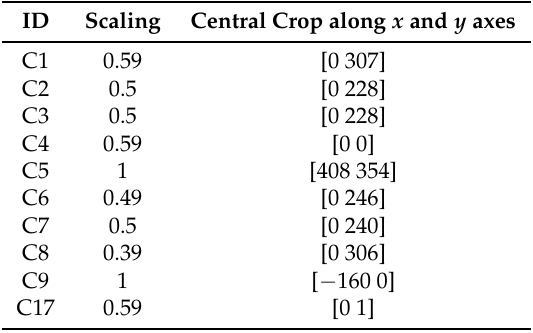
Table 2. Rescaling and cropping parameters linking image and video Sensor Pattern Noises (SPNs) for the considered devices, in absence of in-camera digital stabilization.